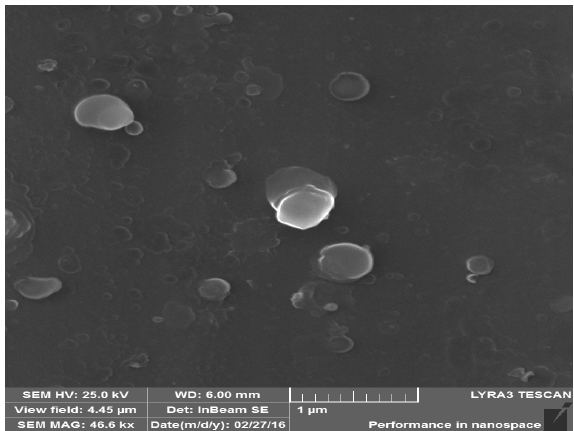
Figure 7. SEM micrograph of sample K2: SiC layer on aluminium alloy